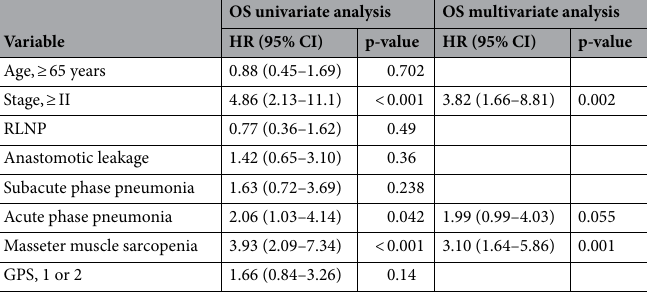
Table 3. Univariate and multivariate analysis for overall survival in patients after esophagectomy. RLNP, recurrent laryngeal nerve paralysis; GPS, Glasgow prognostic